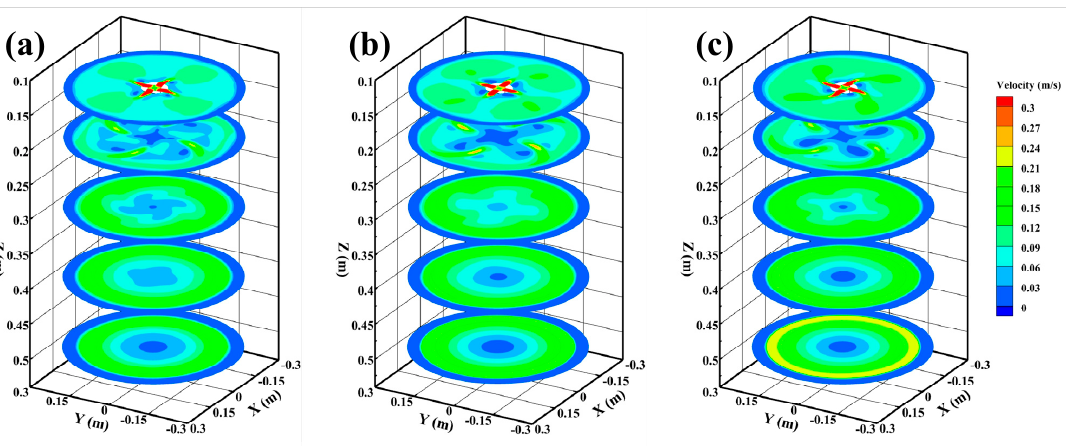
Figure 12. Velocity distributions in cross section of strand with M-EMS ( a ) –15° SFN, ( b ) 0° SEN, and ( c ) +15° SFN.